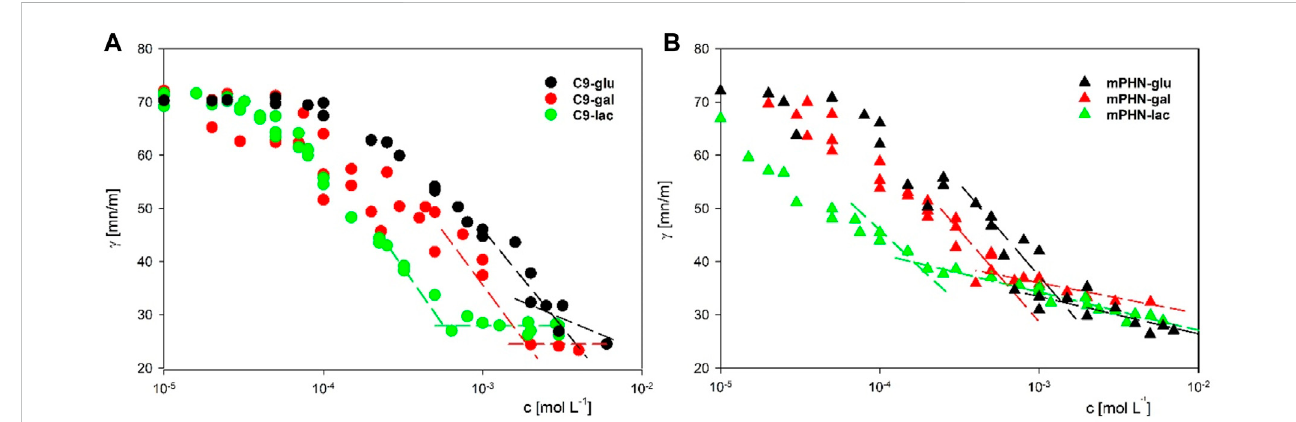
FIGURE 2 The surface tension dependency on surfactants concentration (A) C9-glu black circles; C9-gal red circles; C9-lac green circles (B) mPHN-glu black triangles; mPHN-gal red triangles; mPHN-lac green triangles. The intersection of the lines indicates the concentration at which the slope of the surface tension isotherms changes signi fi cantly, which is conventionally taken as